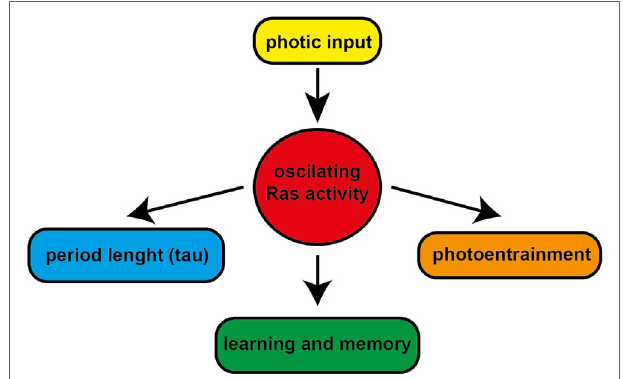
FiGURe 2 | The role of Ras in the regulation of circadian clockwork and learning and memory. The circadian and photic regulation of Ras activity in the suprachiasmatic nucleus modulates the light-induced phase resetting of the clock and fine tunes the circadian period length. The circadian modulation of Ras signaling might have potential role in learning and